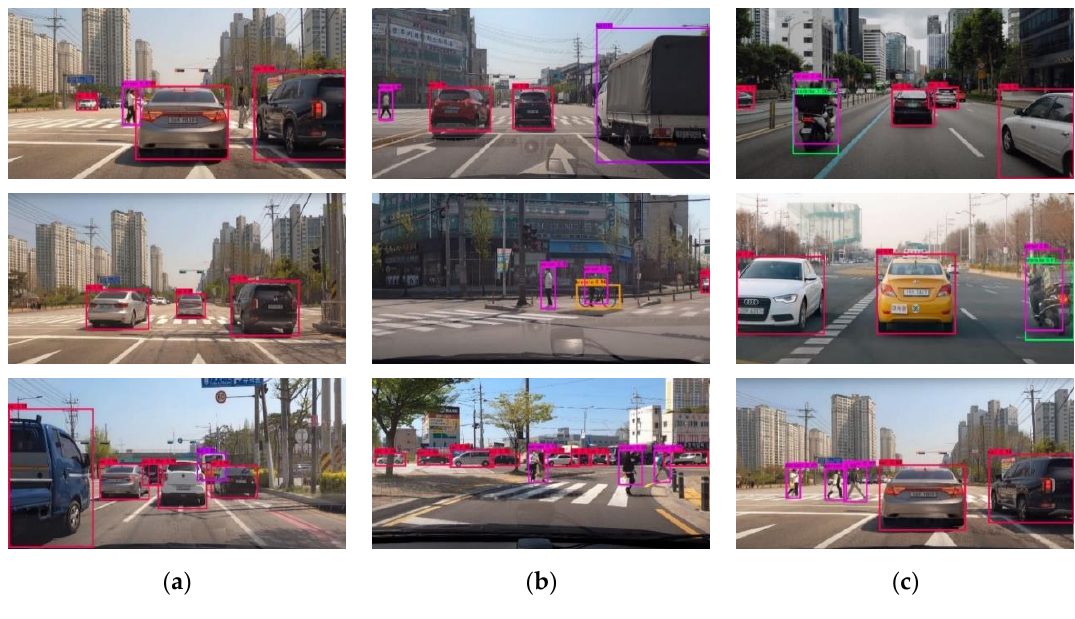
Figure 17. Object detection results of the proposed model in real situations. ( a ) detection results of various vehicles on the road, ( b ) detection results of pedestrians and bicycles on the road, and ( c ) detection results of motorcycles and surrounding vehicles while the vehicle is moving.